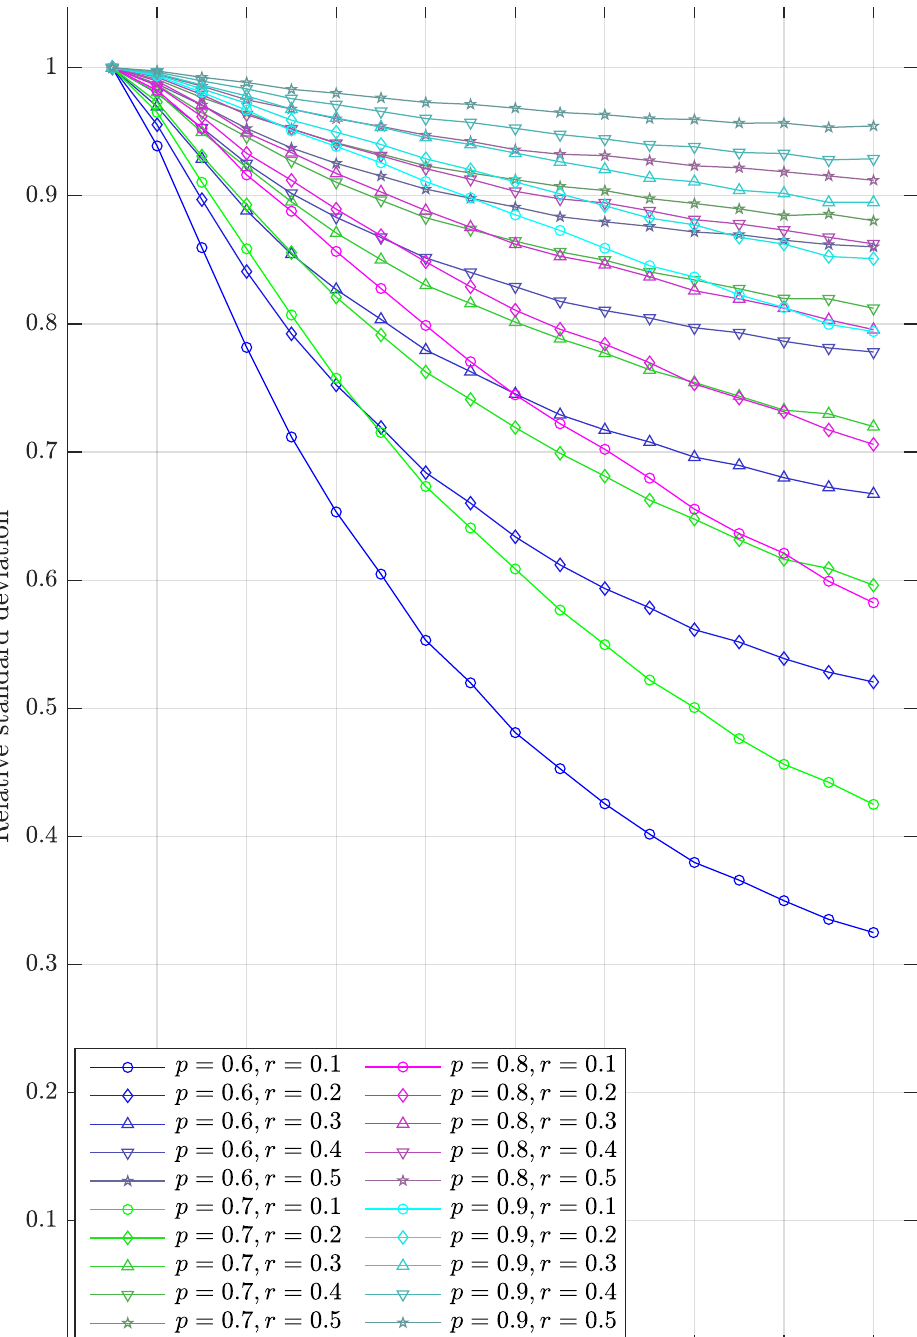
Figure 5. Relative standard deviation (heteroskedastic rms over homoskedastic rms) of the fitted angle Φ for all 20 combinations of p and r in the range 3 ≤ n ≤